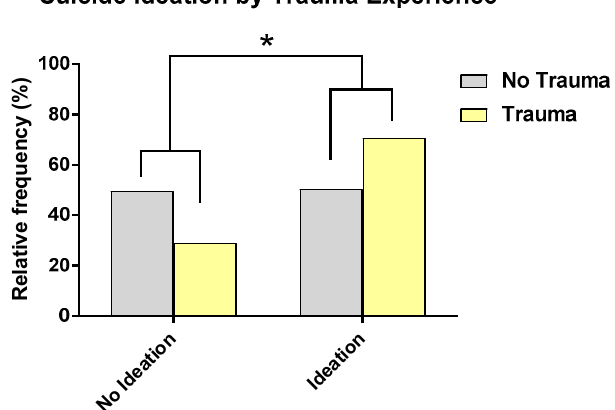
Figure 3. Participants with a history of suicide ideation were more likely to report a history of trauma than those without suicide ideation. * p < 0.05.